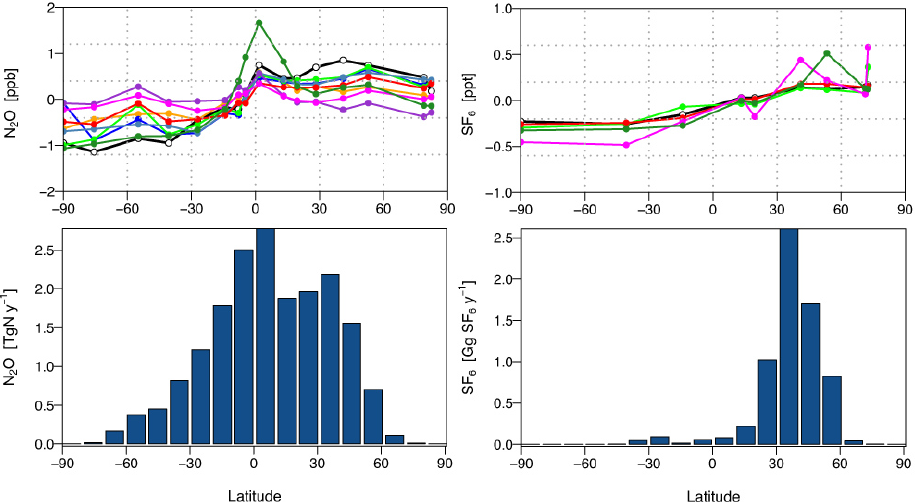
Fig. 5. Comparison of the meridional gradients of N 2 O (left) and SF 6 (right) using the OCNPIC scenario. Shown are the annual mean mixing ratio at background surface sites (upper panel) and the total zonal and annual prior emission estimate (lower panel). Legend: Mozart4, yellow; ACTMt42l32, blue; ACTMt42l67, green; TM5, grey-blue; TM3-NCEP, purple; TM3-ERA, red; LMDZ4, magenta; TOMCAT, dark green; observed, black.